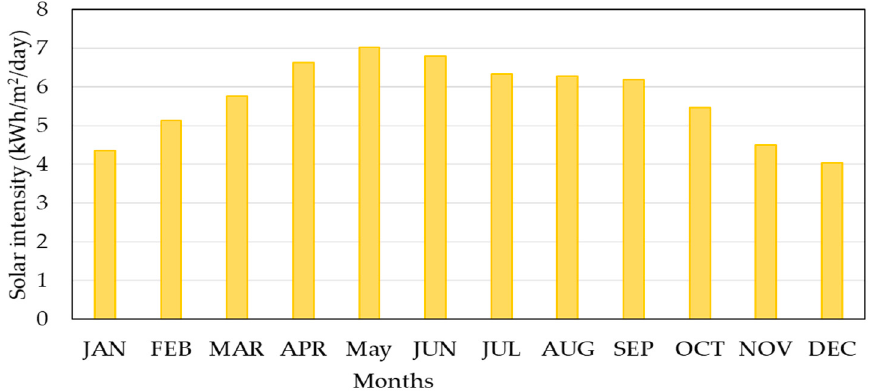
Figure 7. Monthly average solar irradiation profile in the Al-Dhafrat area.